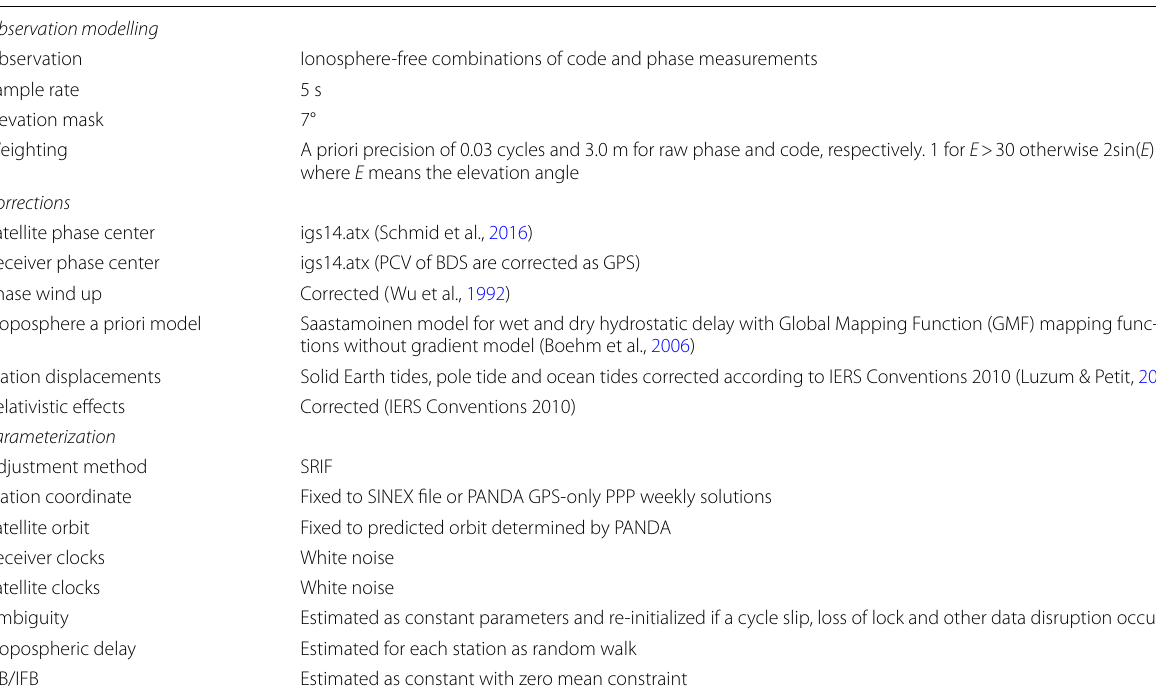
Table 1 Modeling and parameterization strategy for multi-GNSS real-time satellite clock